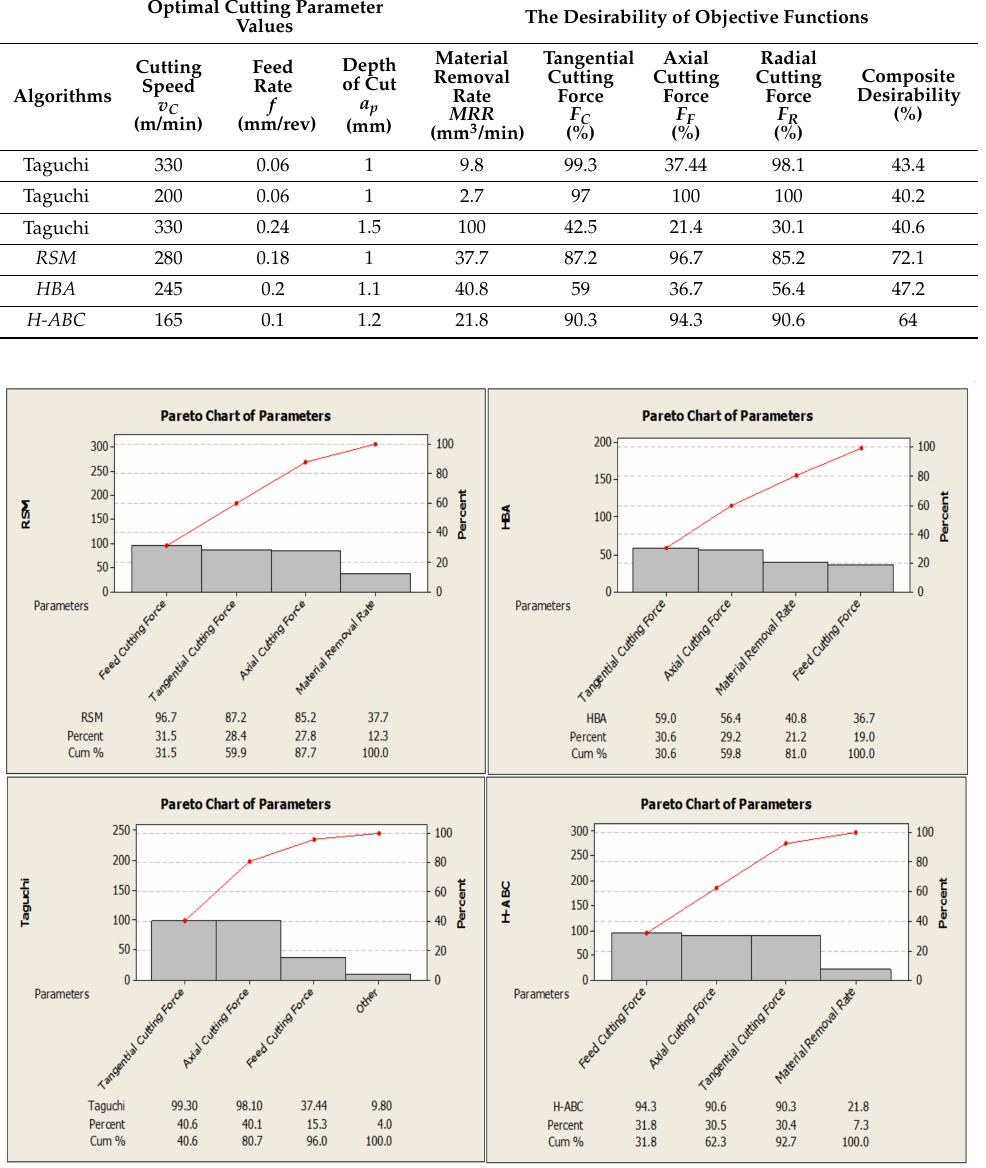
Figure 7. Pareto frontiers of the calculated results for the different optimization